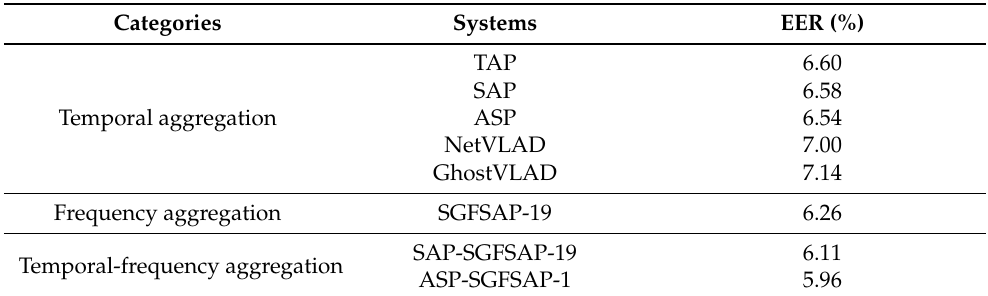
Table 4. The experimental results of CNN-based SV systems with different aggregation methods.